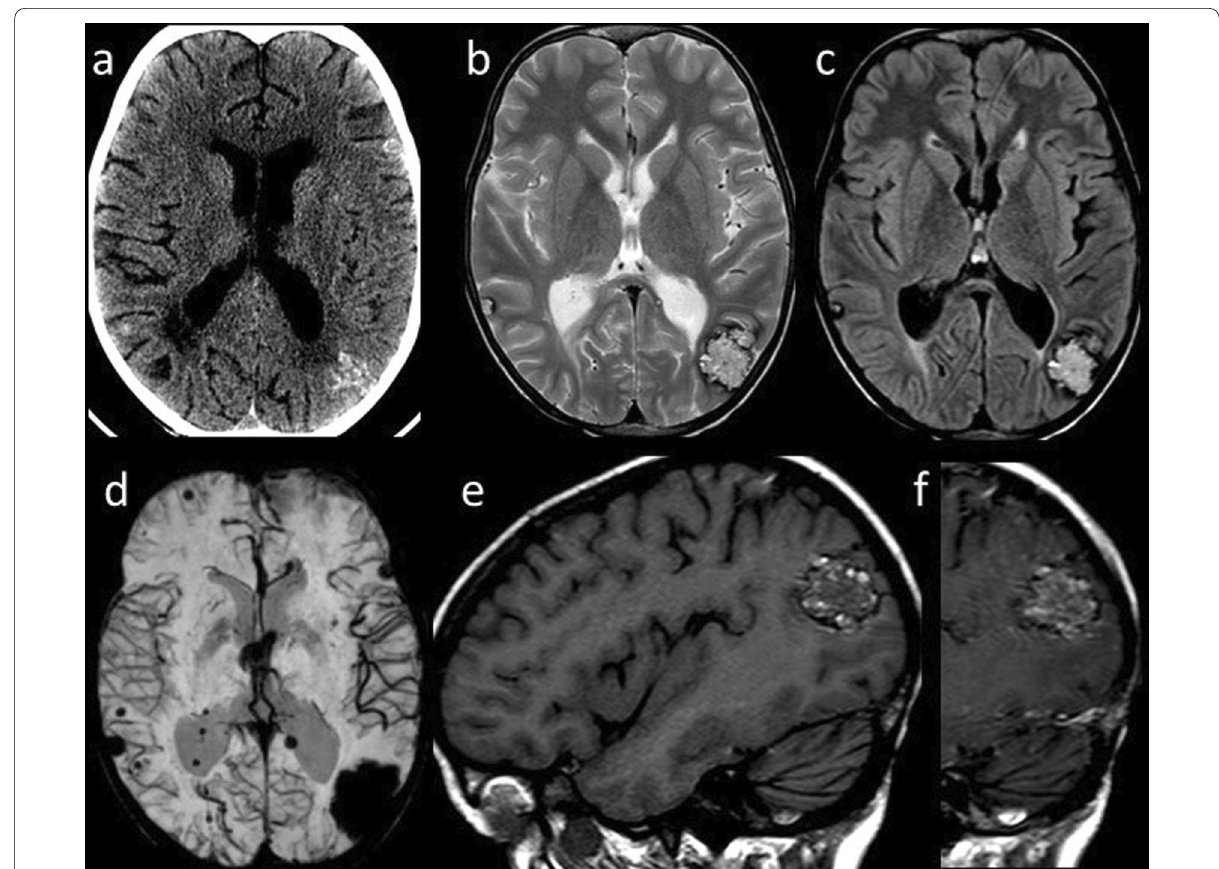
Fig. 3 Radiation-induced vascular malformations (1). Axial CT image ( a ) of a 15-year-old male, treated for medulloblastoma 10 years before with surgery, whole-brain RT and ChT, shows multiple hyperdense brain lesions. Axial T2-weighted ( b ) and FLAIR ( c ) images show corresponding inhomogeneous lesions, and SWI minIP ( d ) confirms multiple “blooming” hypointense foci related to blood products. Sagittal T1-weighted images before ( e ) and after ( f ) contrast injection show spontaneous hyperintensity and patchy enhancement of the parieto-occipital